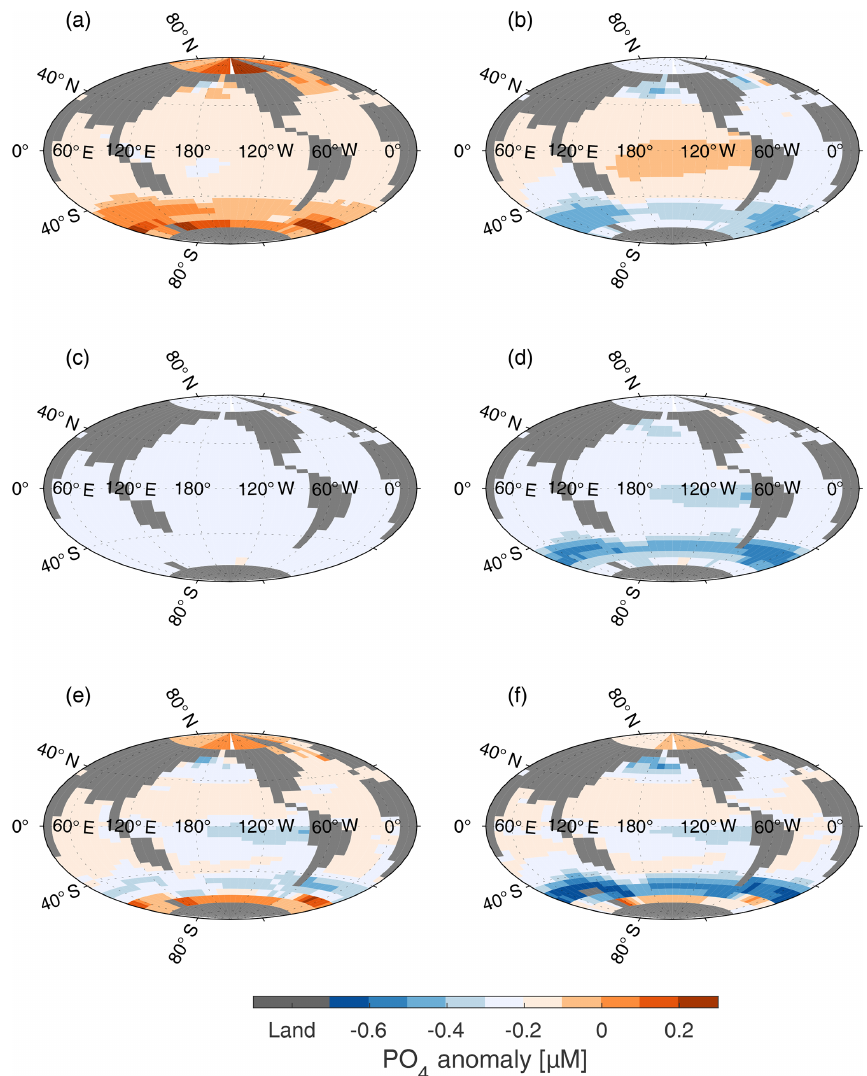
Figure 7. Surface PO 4 anomaly (µM), with respect to surface concentration of PO 4 in Ctrl GAM (Fig. 3a), for (a) LGMphy GAM , (b) WSN × 0 . 5 GAM (c) RLS × 1 . 25 GAM , (d) LGMdust GAM , (e) Acomb GAM , and (f) GLcomb GAM . Changes in surface nutrient fields are similar for all three model versions (RED, GAM, 121); thus only GAM is